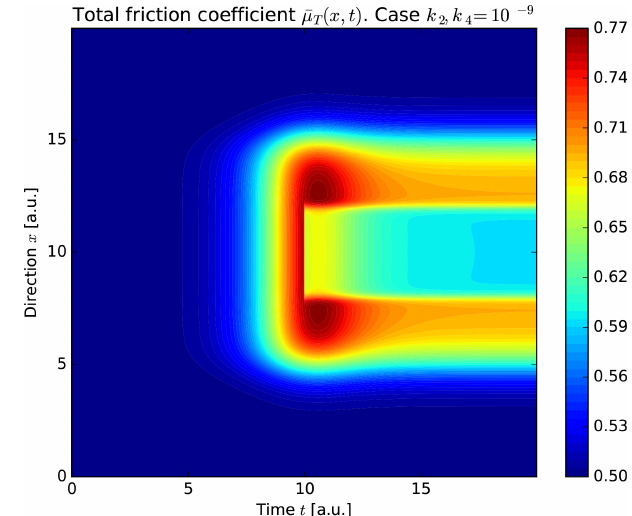
Figure 7. Spatial distribution of γ and γ 2 . These functions repre- sent the different sections (or behavior) of friction on the fault along the x direction. The distribution γ 2 represents the stress drop sec- tion and distribution γ represents the semibrittle–plastic influence region.